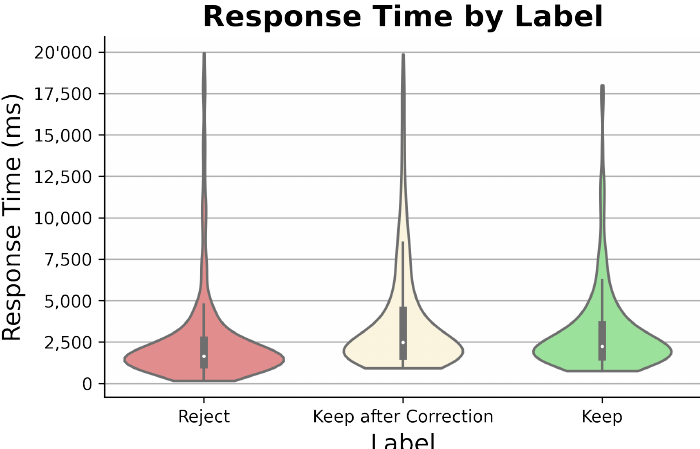
Figure 2. Distribution of users’ response time by signals’ quality